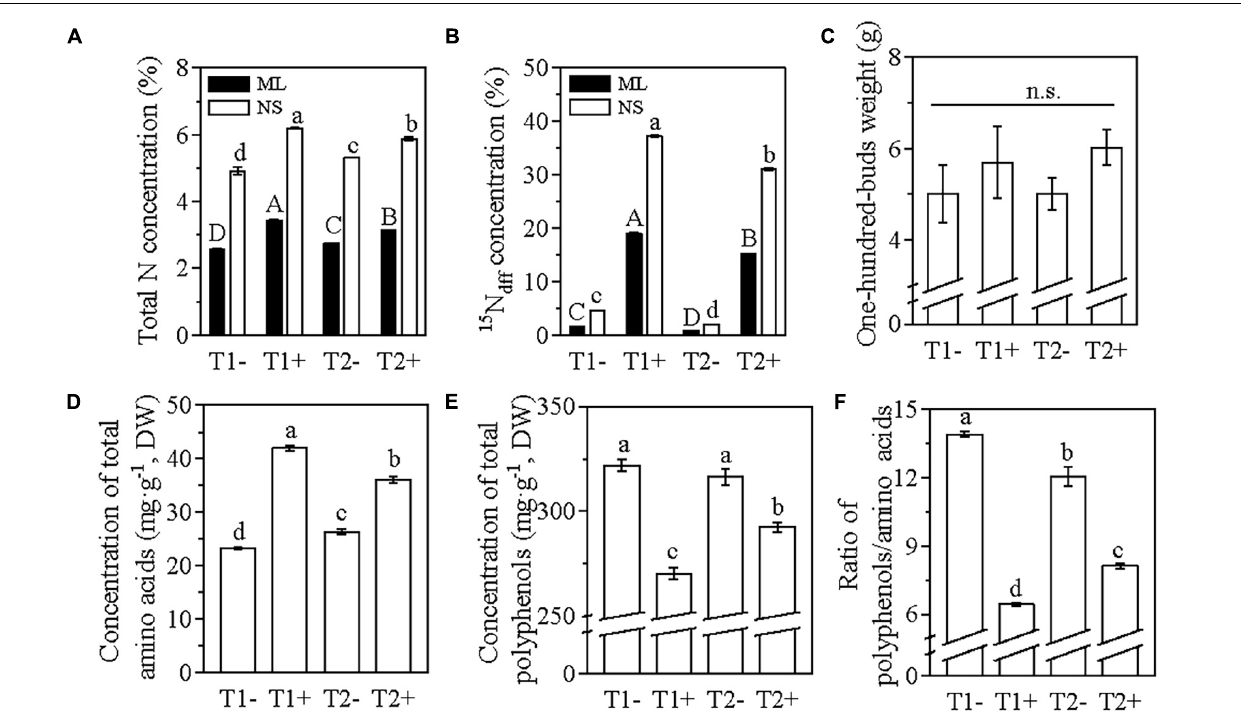
FIGURE 8 | The 15 N-labeling pot experiment investigating the effect of foliar N application on tea plants grown under a reduced soil N fertilization level. (A) The concentration of total N in mature leaves and new shoots (NS). (B) 15 N derived from the 15 N-urea in ML before the sprouting of dormant buds and in NS sprouted from the dormant buds. (C–F) Spring tea, one bud, and two leaves samples. T1, 25% reduced soil N level (1.5 g of pure N per pot) without (T1 − ) or with (T1+) foliar 15 N-urea application; T2, local soil N fertilization level (2 g of pure N per pot) without (T2 − ) or with (T2+) foliar 15 N-urea application. DW, dry weight. Data represented mean ± SE; n = 3 for samples in panels (A,B,F) ; n = 5 for samples in panel (C) ; n = 9 for samples in panel (D) ; n = 6 for samples in panel (E) . Lowercase letters indicated significant differences of NS, while capital letters indicated the significance of ML ( P < 0.05; ANOVA, followed by the Duncan